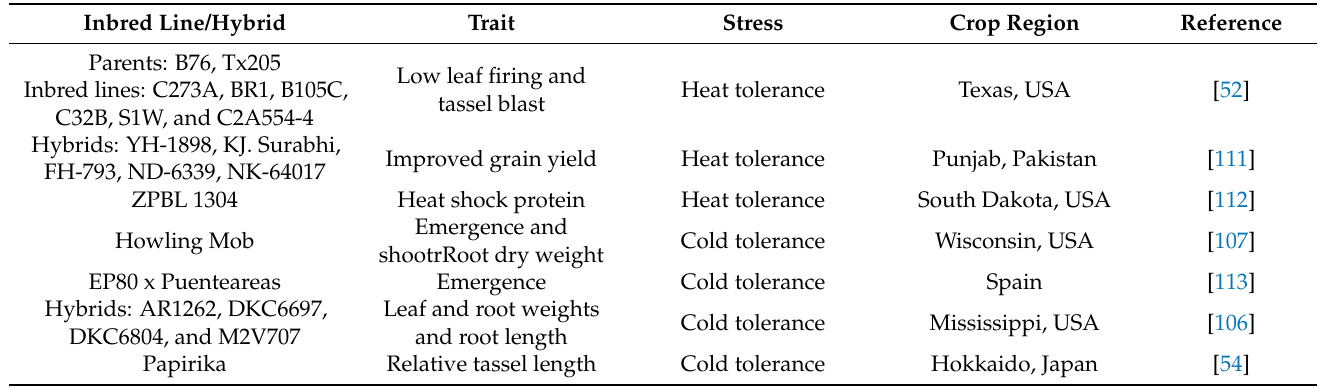
Table 4. Cold-/heat-tolerant maize genotypes developed using conventional breeding methods. Inbred